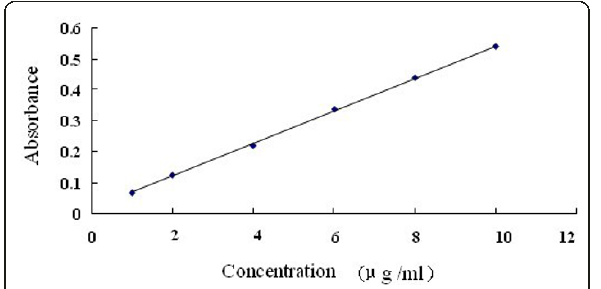
Figure 1 The calibration curve of gallic acid . linear range (1~10 μ g/ml), Regression equation(Y = aX + b): y = 52.496x + 0.0163, R 2 = 0.9993(n =